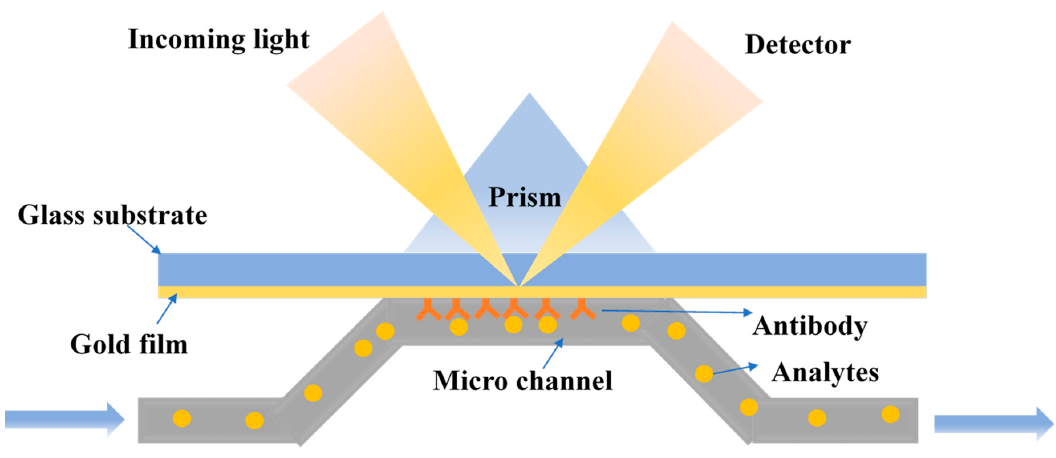
Figure 4. The principle of surface plasmon resonance detection.